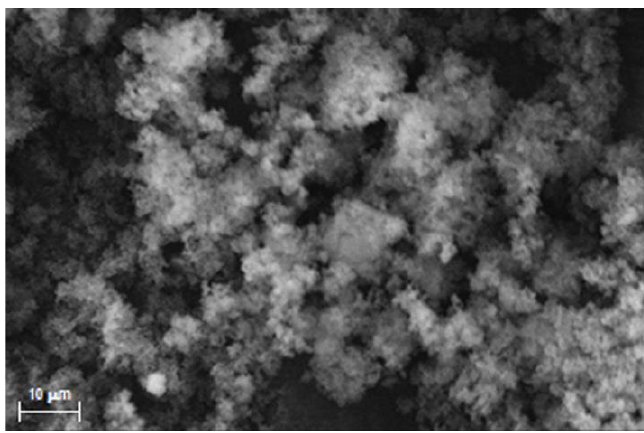
Figure 3. SEM image of RAC-MIP (3000× magnification). Synthesized MIPs were also analyzed by FTIR analysis (Figure 4).